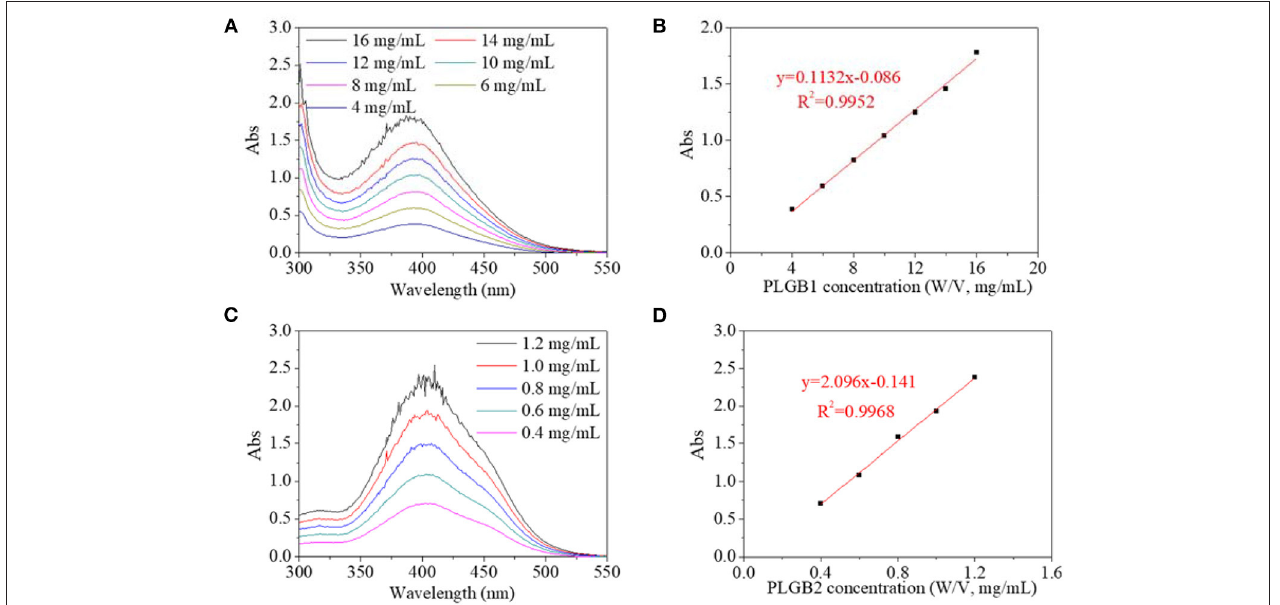
FIGURE 4 | UV spectra of (A) PBLG1 and (B) PBLG2 with different polymer concentration; (C) absorbance of PBLG1 at 390nm as a function of PBLG1 concentration; (D) absorbance of PBLG2 at 400nm as a function of PBLG2 concentration.